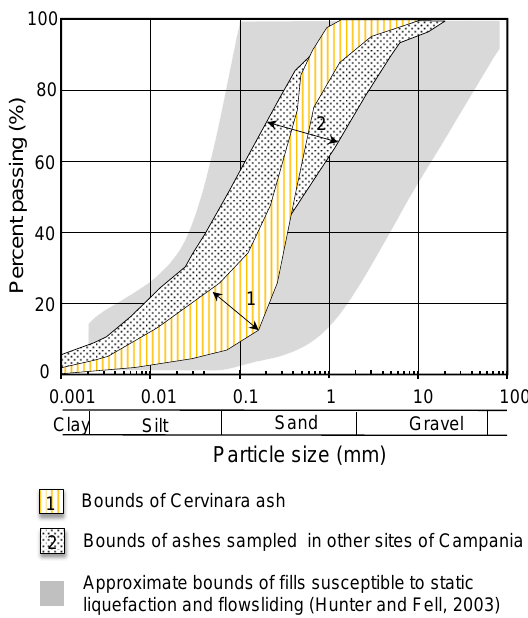
Figure 2. The grain size of eight different deposits of air-fall volcanic ashes in Campania.